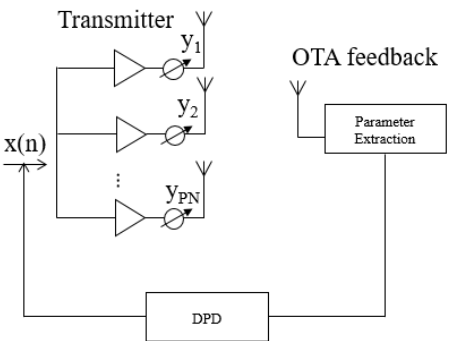
Figure 6. Block diagram representing the steps to apply the single-receiver OTA DPD with antenna crosstalk using OTA measurements method.